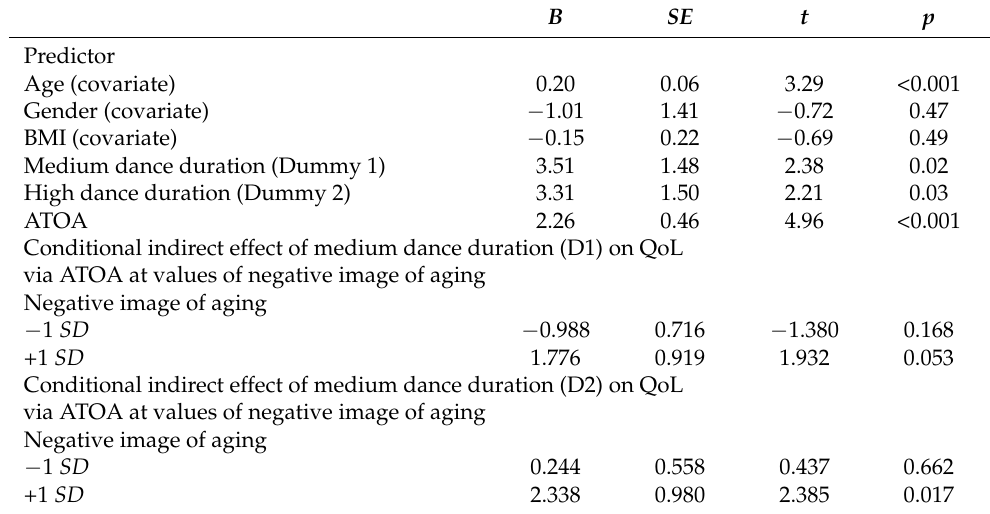
Table 3. Regression results on QoL in model with negative image of